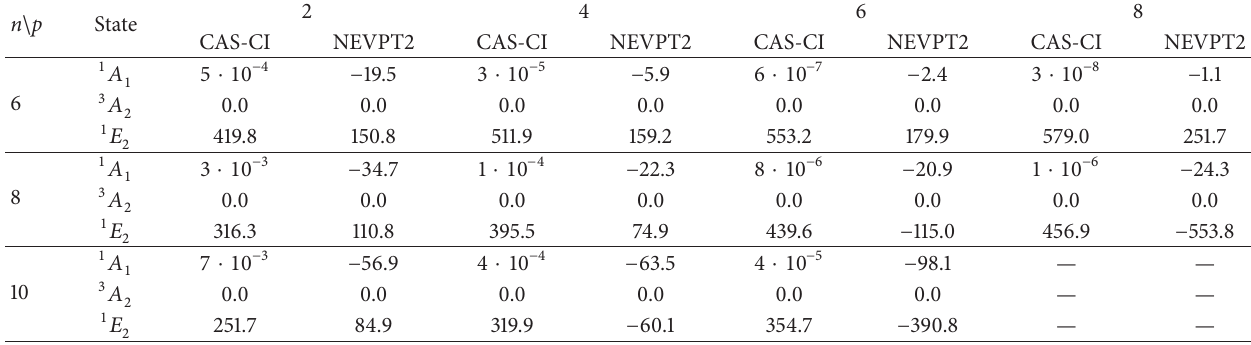
Table 2: CAS-CI and the NEVPT2 energies in kJ mol −1 for the class of nanotubes 𝑛 𝑝 , with 𝑛 even and 𝑝 even. All possible states for a CAS of two electrons in two orbitals have been calculated.